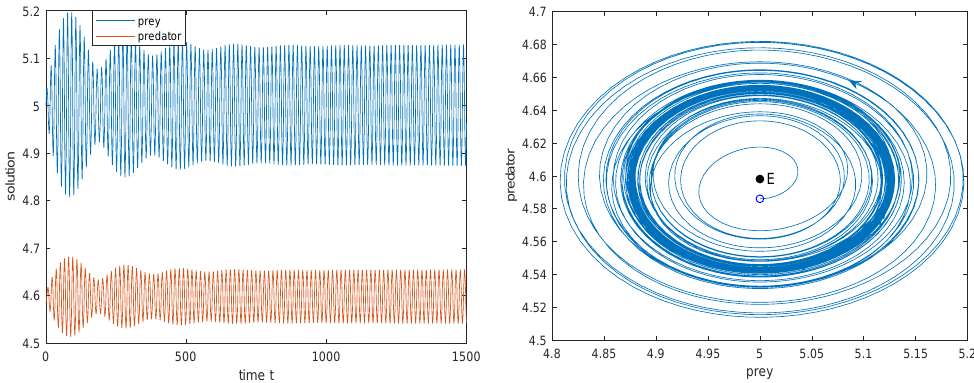
= 14.6232, the subcritical Hopf bifurcation occurs at E in . Initial value: ( φ 1 , φ 2 ) = ( 5,4.586 ) . Figure 9. τ = τ − 0